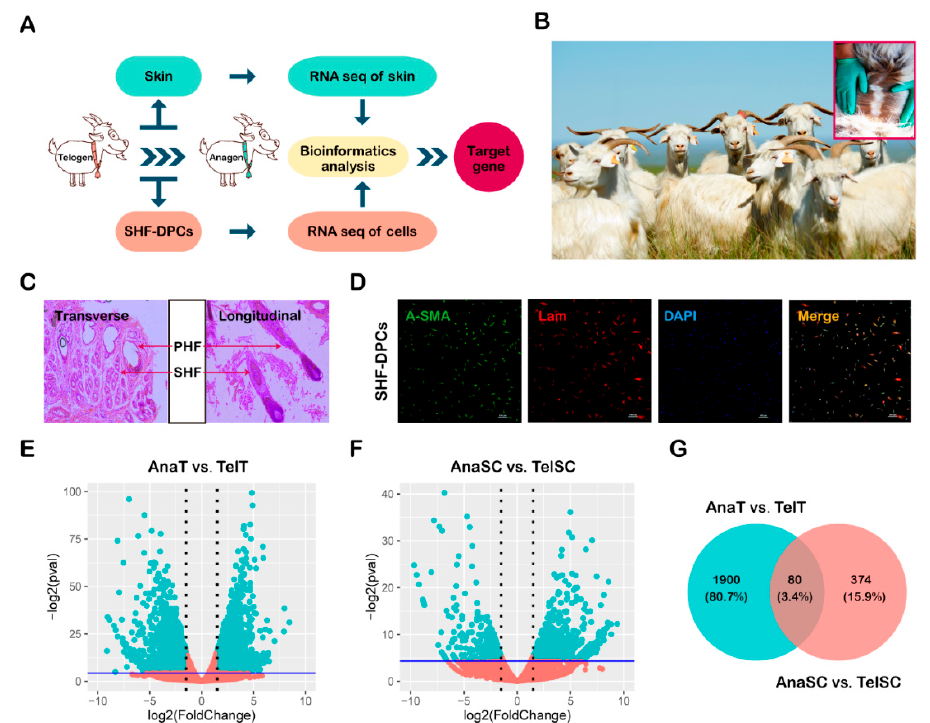
Figure 1. Transcriptomic analysis of overlapping differentially expressed genes (DEGs) from hair follicle (HF) anagen to telogen of Albas cashmere goat. ( A ) Our experimental workflow. ( B ) Albas cashmere goats living on the Inner Mongolia Plateau. The red frame shows where cashmere grows. ( C ) Hematoxylin-eosin (H&E) staining of skin in transverse and longitudinal section. Arrows indicate the primary hair follicle (PHF) and the secondary hair follicle (SHF). ( D ) Identification of dermal papilla cells of secondary hair follicle (SHF-DPCs) using anti- α smooth muscle actin ( α -SMA) (green) antibody and anti-laminin antibody (red). SHF-DPCs were positive for both antibodies and nuclei were marked by 4 (cid:48) ,6-diamidino-2-phenylindole (DAPI) staining (blue). ( E–F ) Volcano plot of all genes in the skin and SHF-DPCs samples of HF anagen and telogen of Albas cashmere goat, showing genes with > 2-fold di ff erence and an adjusted p < 0.01 among groups. AnaT, the skin tissue of HF anagen; TelT, the skin tissue of HF telogen, AnaSC, the SHF-DPCs of HF anagen, TelSC, the SHF-DPCs of HF telogen. ( G ) Venn diagram illustrating the number of overlapping di ff erentially expressed genes (overlapping DEGs) between AnaT vs. TelT and AnaSC vs. TelSC.